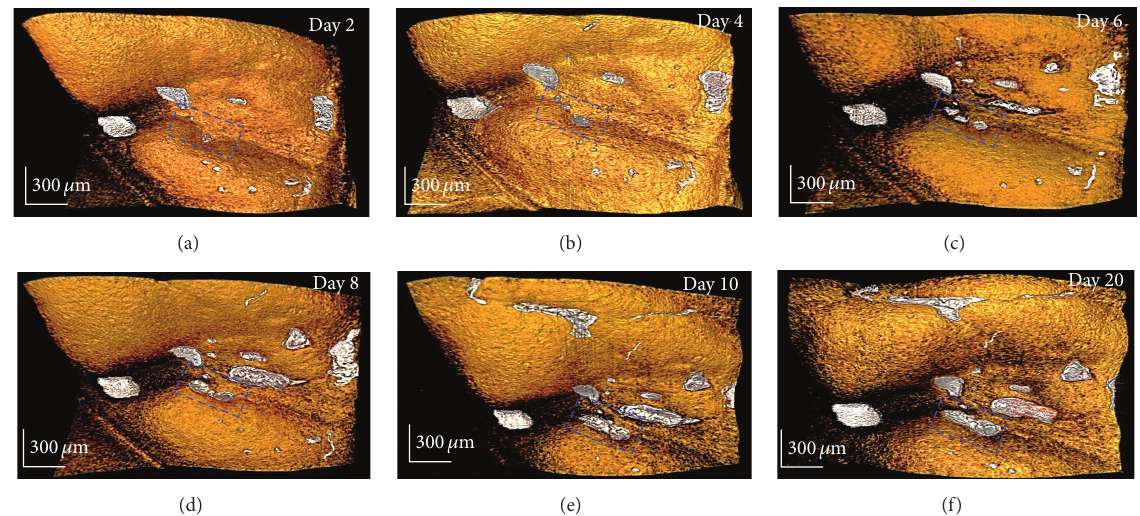
Figure 4: 3D SD-OCT images. Images (a) to (f) are 3D images highlighted with blue dashed box region of same position showing disease growth; all 3D images are processed with 2D